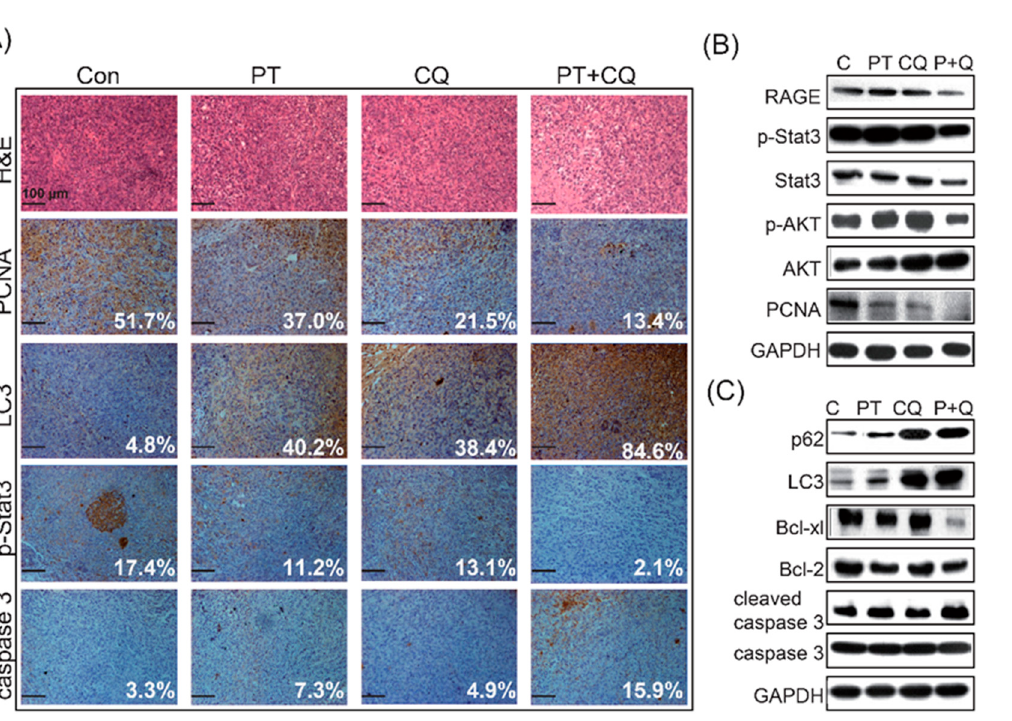
Figure 6. The combination of PT and CQ induces the expression of apoptosis-related proteins, and downregulates the expression of autophagy and RAGE/STAT3 signaling pathways in tumor tissues. ( A ) Pancreatic tumors were examined via H&E staining and immunohistochemistry to analyze the expression levels of PCNA, LC3, p-STAT3, and caspase-3, using FlowJo software. Scale bar = 100 μ m. ( B ) PT and CQ treatment—alone or in combination—decreased the expression levels of RAGE, p-STAT3, STAT3, p-AKT, AKT, and PCNA in tumor tissues, while inhibition of autophagy was determined by the accumulation of p62 and LC3 ( C ). ( C ) Apoptosis in tumors treated with PT and CQ—alone or in combination—showed the expression of p62, LC3, Bcl-xl, Bcl-2, cleaved caspase-3, and caspase-3 via Western blotting. The membrane was probed with anti-GAPDH to confirm equal loading of proteins. Immunoblots are representative of at least three independent experiments.